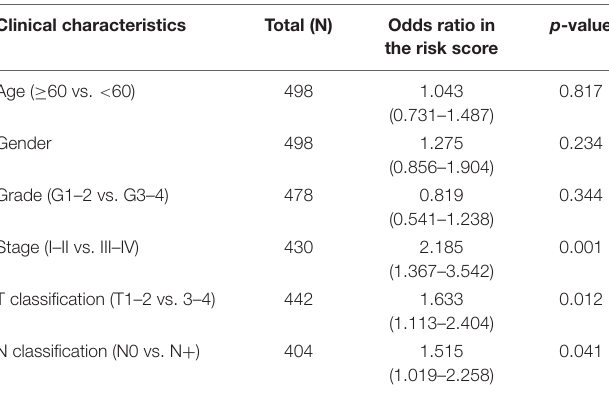
TABLE 3 | Association analysis between the clinical factors and the risk score in SCCHN patients of TCGA data set using logistic regression. Clinical